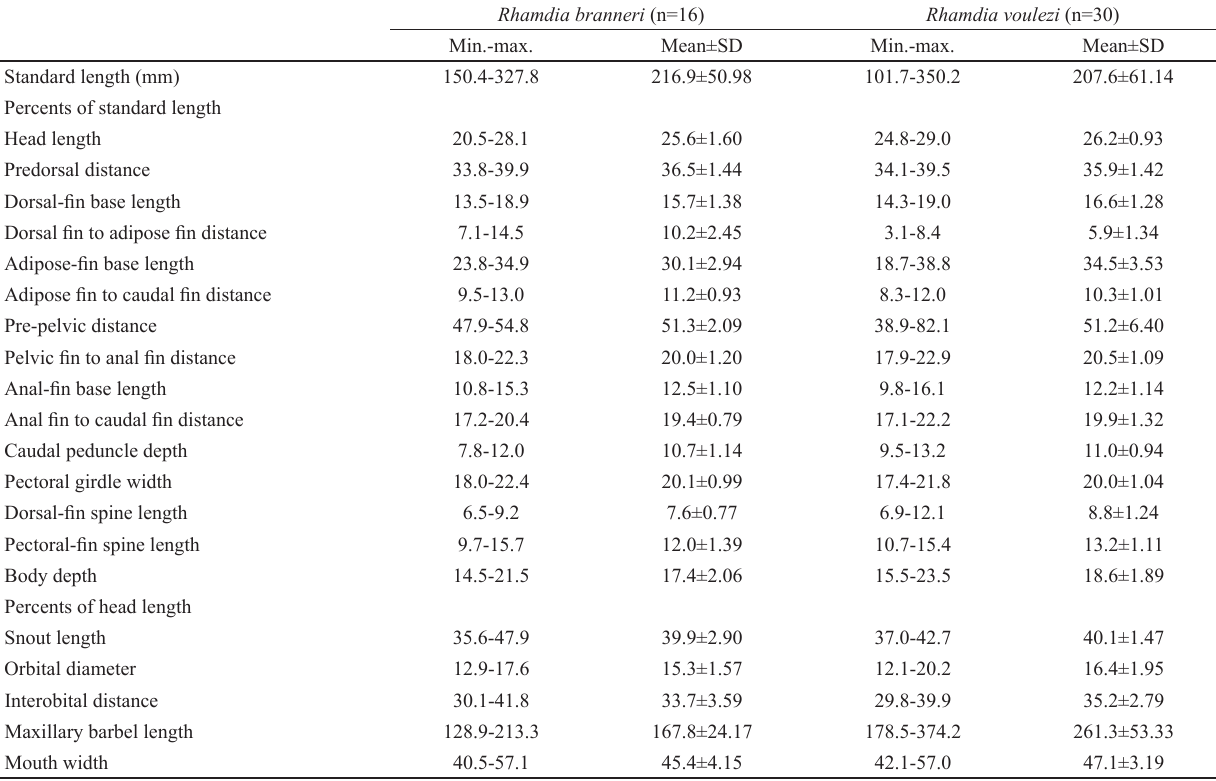
Table 1. Body proportions of Rhamdia branneri and Rhamdia voulezi from the rio Iguaçu. SD = Standard deviation.